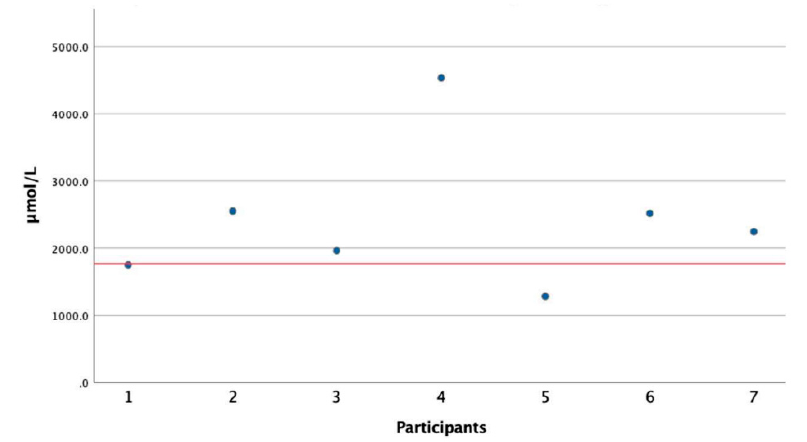
Figure2. D-xyloseconcentrationsinserumonehourafterconsumptionof15gofD-xylose. Thereference Figure 2. D-xylose concentrations in serum one hour after consumption of 15 g of D-xylose. The value for normal intestinal absorption is marked with a red horizontal line. reference value for normal intestinal absorption is marked with a red horizontal line.